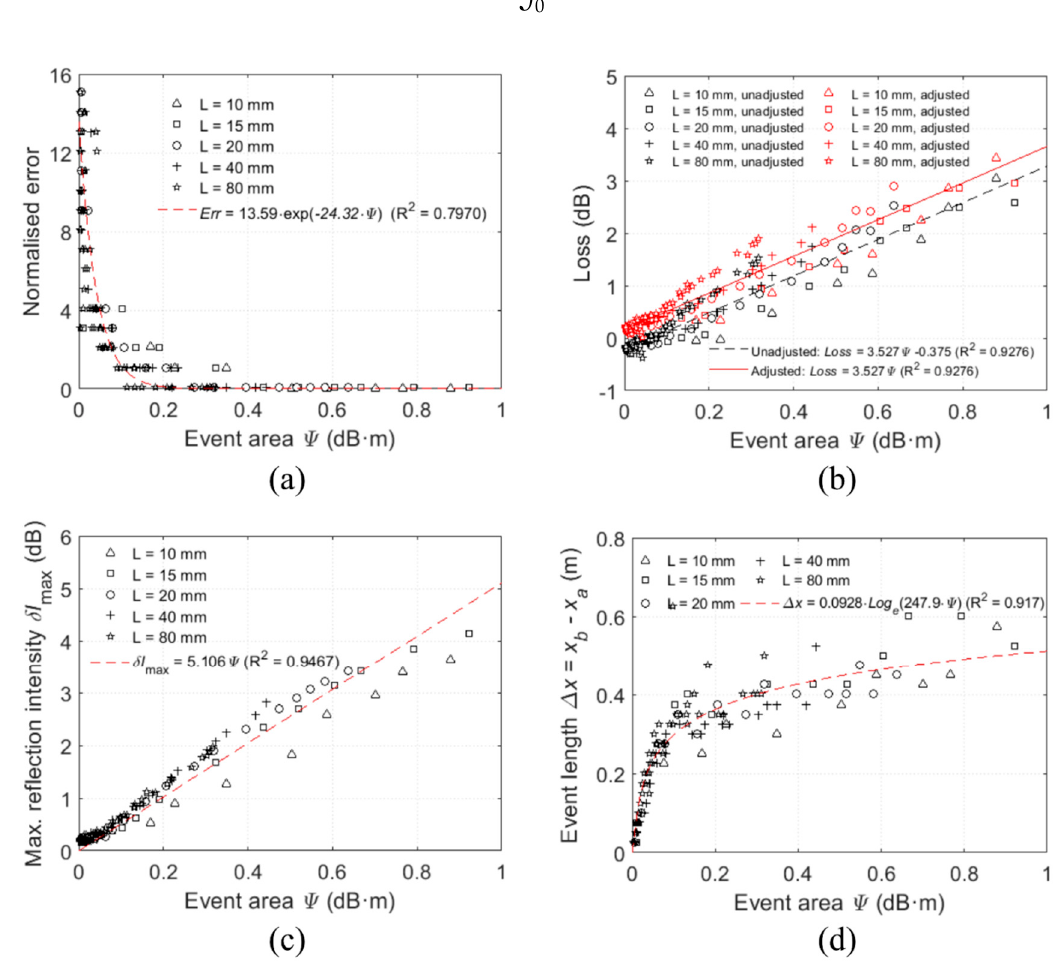
Figure 7. Correlations between event area and other variables: ( a ) Normalised error in detecting the shear event positions; ( b ) energy loss of the light pulses; ( c ) maximum intensity due to reflection; ( d ) event lengths due to shear deflections.